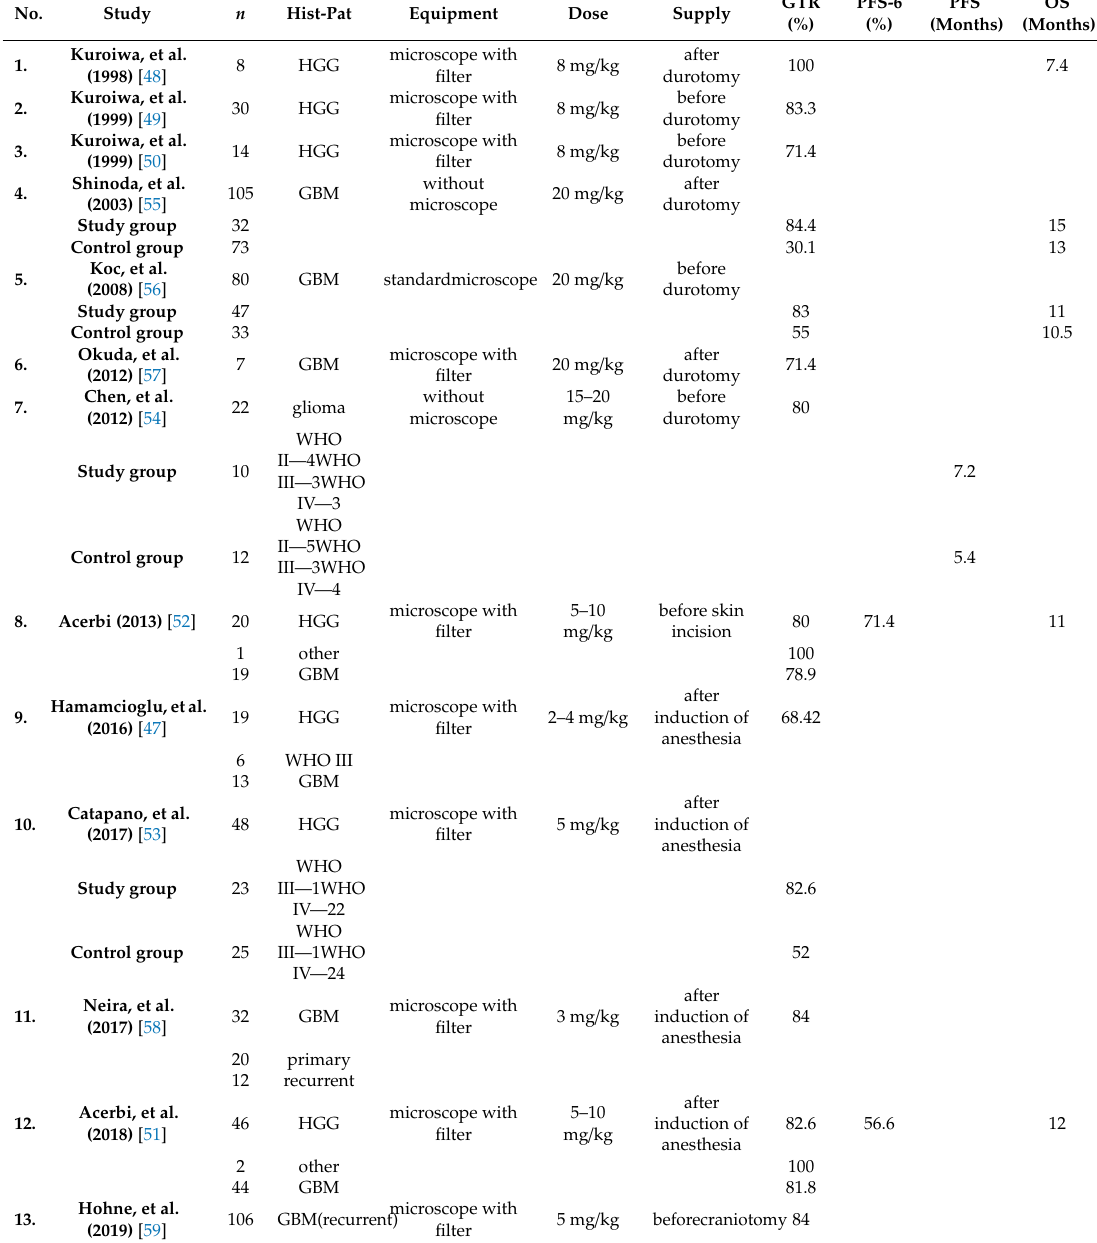
Table 2. Gross total resection rate using intraoperative navigation with